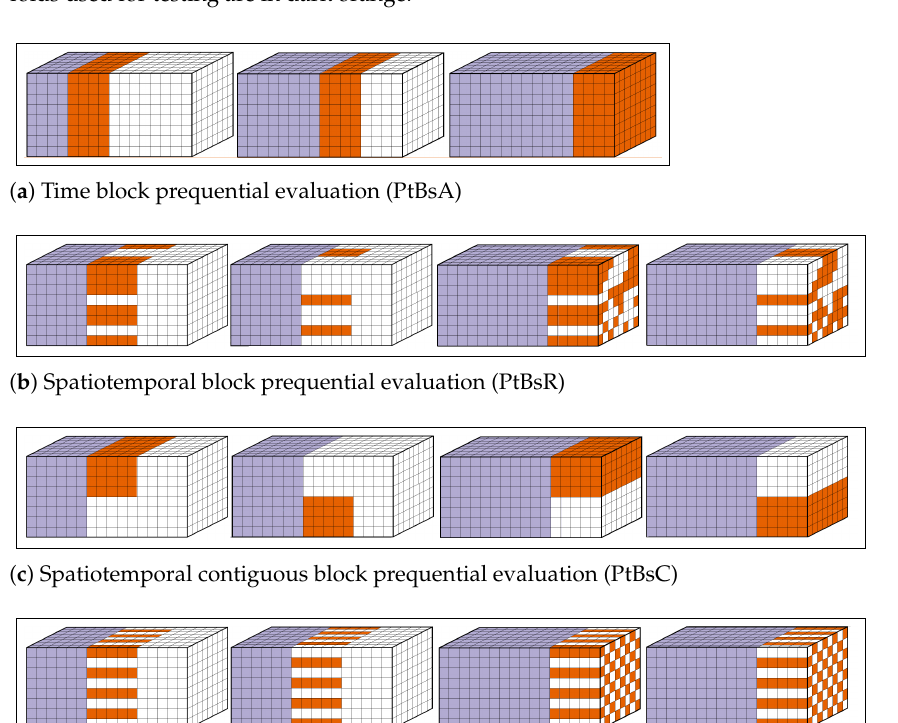
Figure 3. Block cross-validation methods. The folds used for training are in lighter lilac, while the folds used for testing are in dark orange.